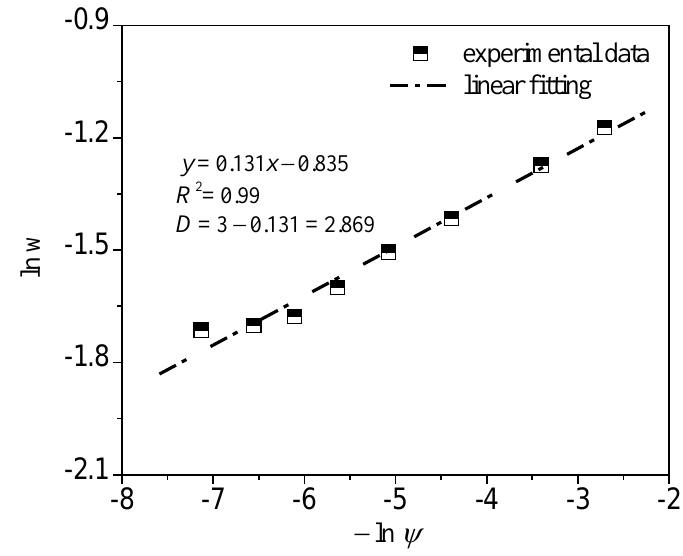
Figure 3. Determination of the values of fractal dimension at reference state through plotting experimental data of ln w against (−ln Ψ ) for Wuhan Clay with e 0 = 1.115.